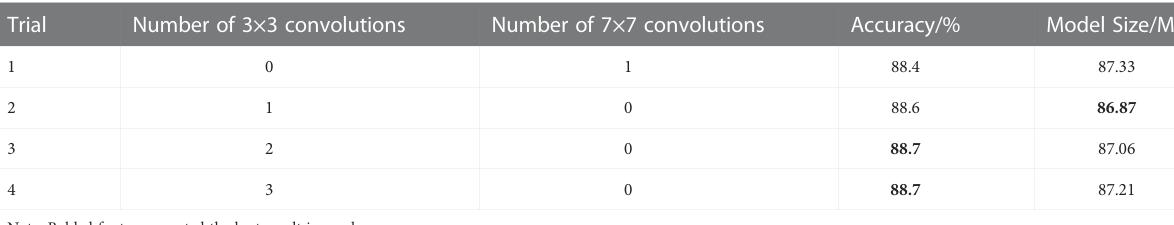
TABLE 3 The effect of convolution kernel number on the ResNet-34 model. Trial Number of 3×3 convolutions Number of 7×7 convolutions Accuracy/% Model Size/MB